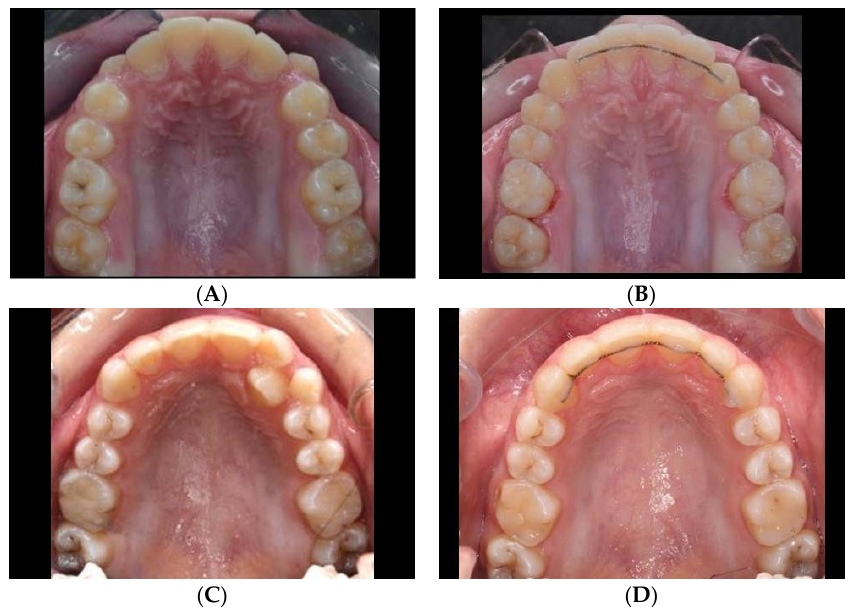
Figure 3. Occlusal views of the maxillary arches of treated patients with corresponding pre-treat- ment (left column, A , C ) and post-treatment (right column, B , D ) images. A total of 47 such pairs were used to test the robustness of the trained network to identify the teeth after their positions were altered through orthodontic treatment.